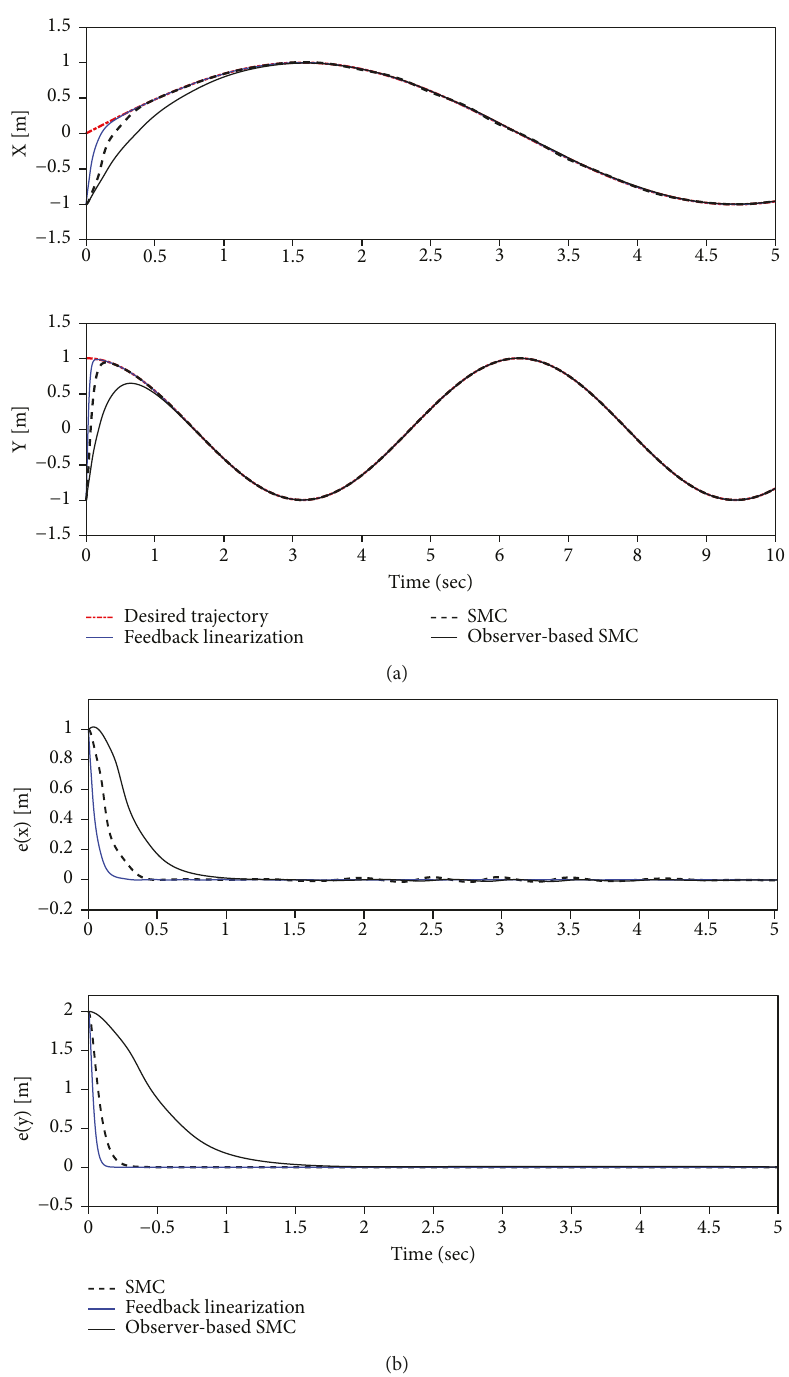
Figure 11: Comparing the observer-based SMC performance with the SMC and feedback linearization controllers: (a) trajectory tracking performance around X and Y directions and (b) trajectory tracking error